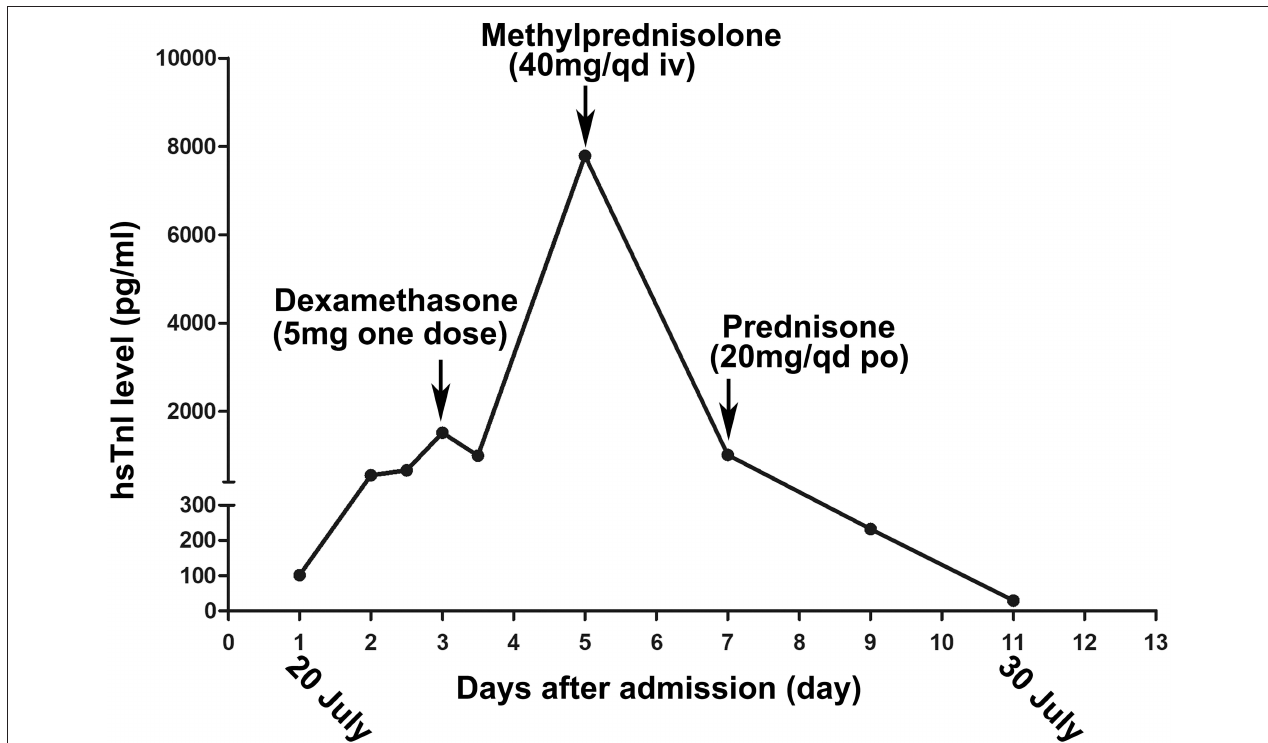
FIGURE 1 | The changing trend of the high-sensitivity cardiac troponin I (hs-cTnI) during her hospitalization. The arrow indicates the times when the patient accepts glucocorticoid treatment.